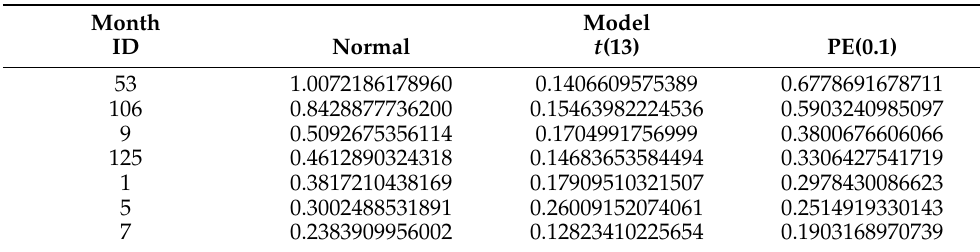
Table 10. Values of total local influence C h ( θ ) under scale perturbations in the indicated model with data of monthly